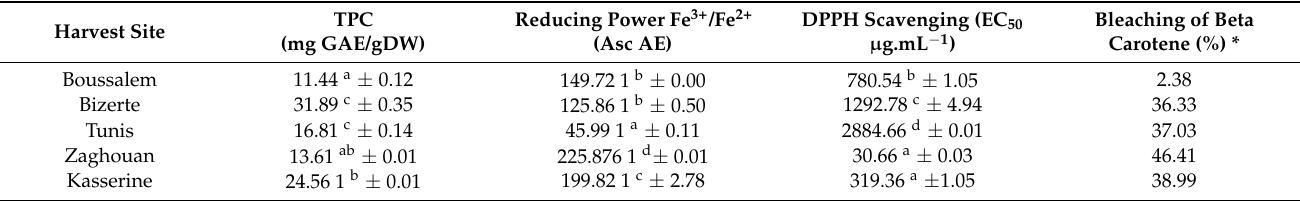
Table 2. Phenolic content and antioxidant activity of M. vulgare